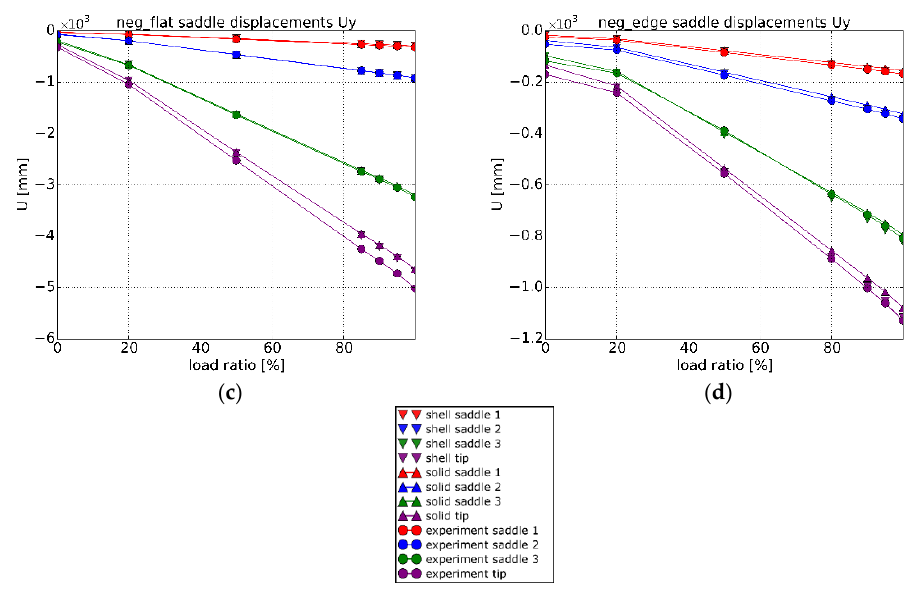
Figure 11. Saddle displacements Uy for the different load cases. ( a ) Positive flatwise load case; ( b ) positive edgewise load case; ( c ) negative flatwise load case; ( d ) negative edgewise load case.